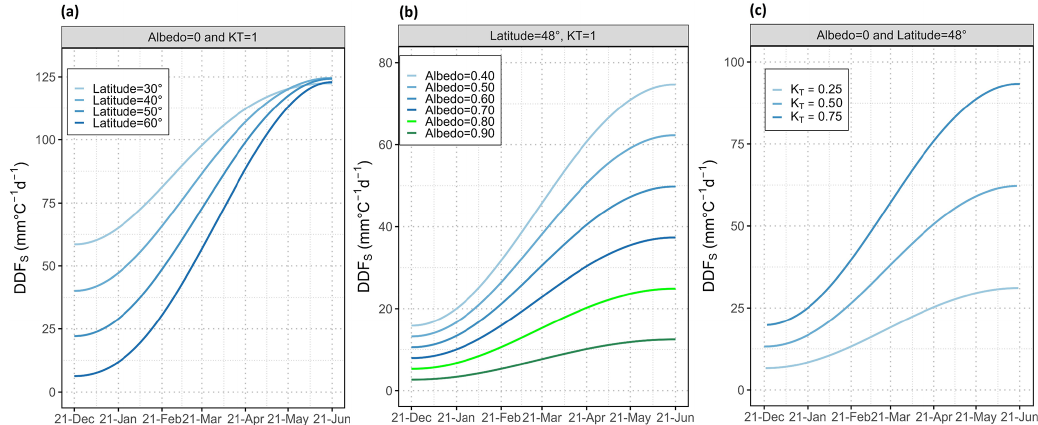
Figure 5. Variation of solar-radiation-based DDF S for a degree-day value of 1 ◦ Cd for (a) different latitudes under constant snow albedo and clearness index, (b) snow albedos under constant latitude and clearness index, and (c) different clearness indices under constant latitude and snow albedo. The latitude = 48 ◦ corresponds to the location of the Brunnenkopfhütte test